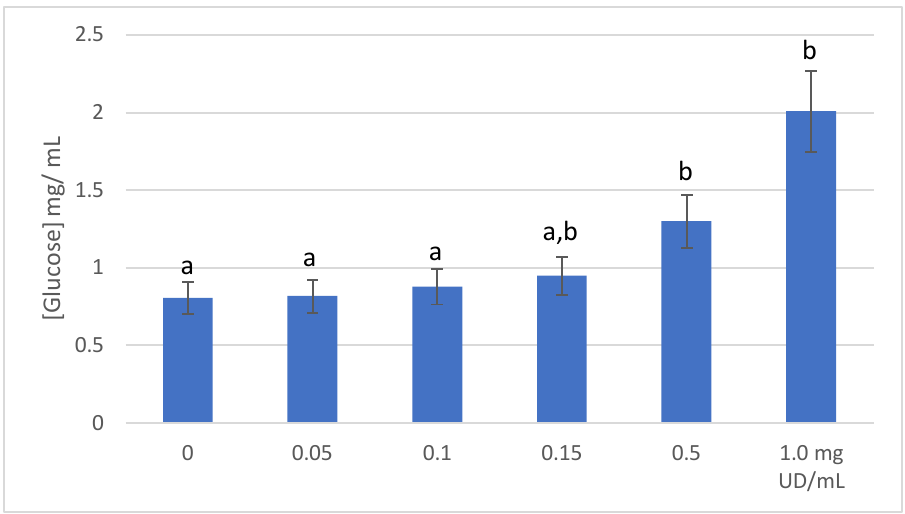
Figure 3. Glucose concentration (mean ± SD, mg/mL) remained in the medium after treating Caco-2 cell with different concentrations of UD extract. Values with different letters are significantly different ( p ≤ 0.05).